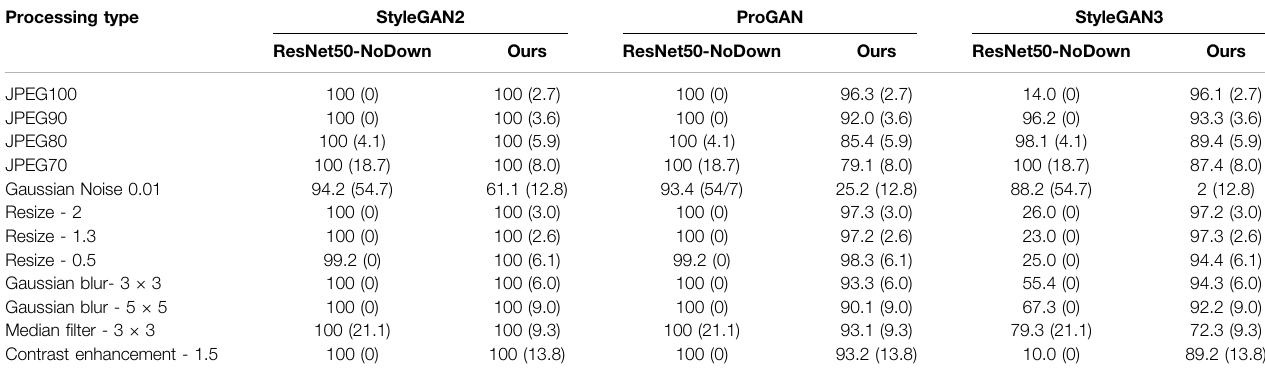
TABLE 4 | Pd@5% (FPR) for the proposed method and the baseline under various image processing operations. The FPR (%) measured on the test set is reported among brackets. Tests are carried out in matched (StyleGAN2) and mismatched (ProGAN and StyleGAN3) conditions. Processing